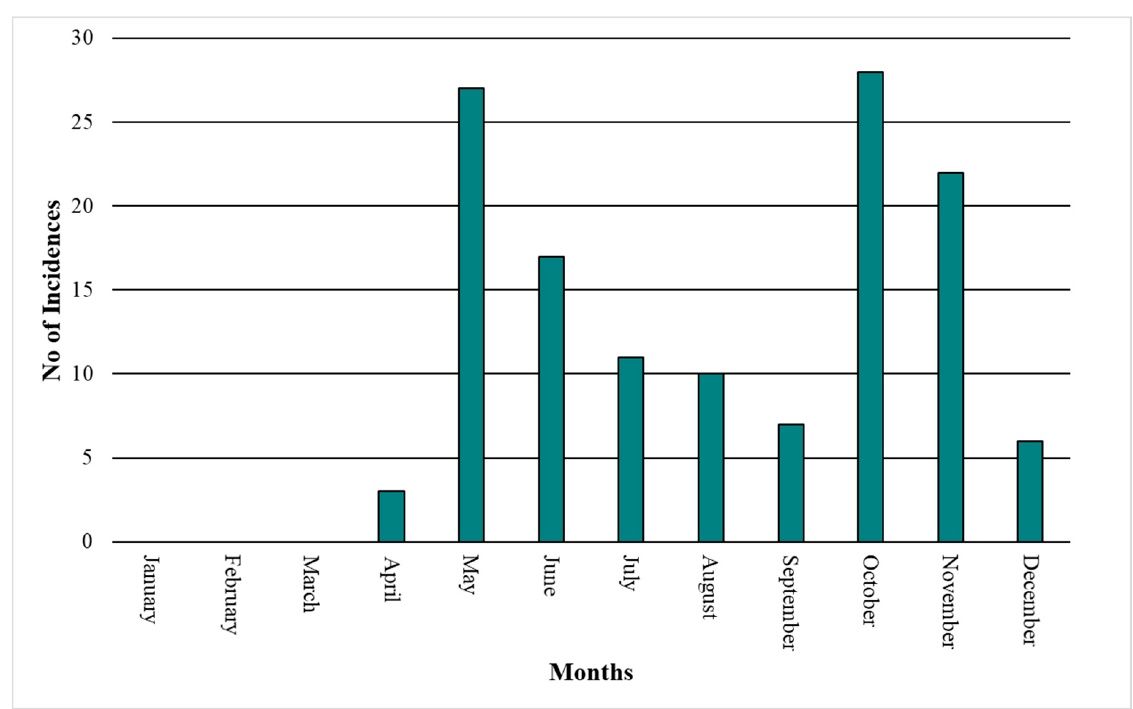
Figure A1. Frequency of Landfalling Cyclones of Bangladesh (1877–2020).